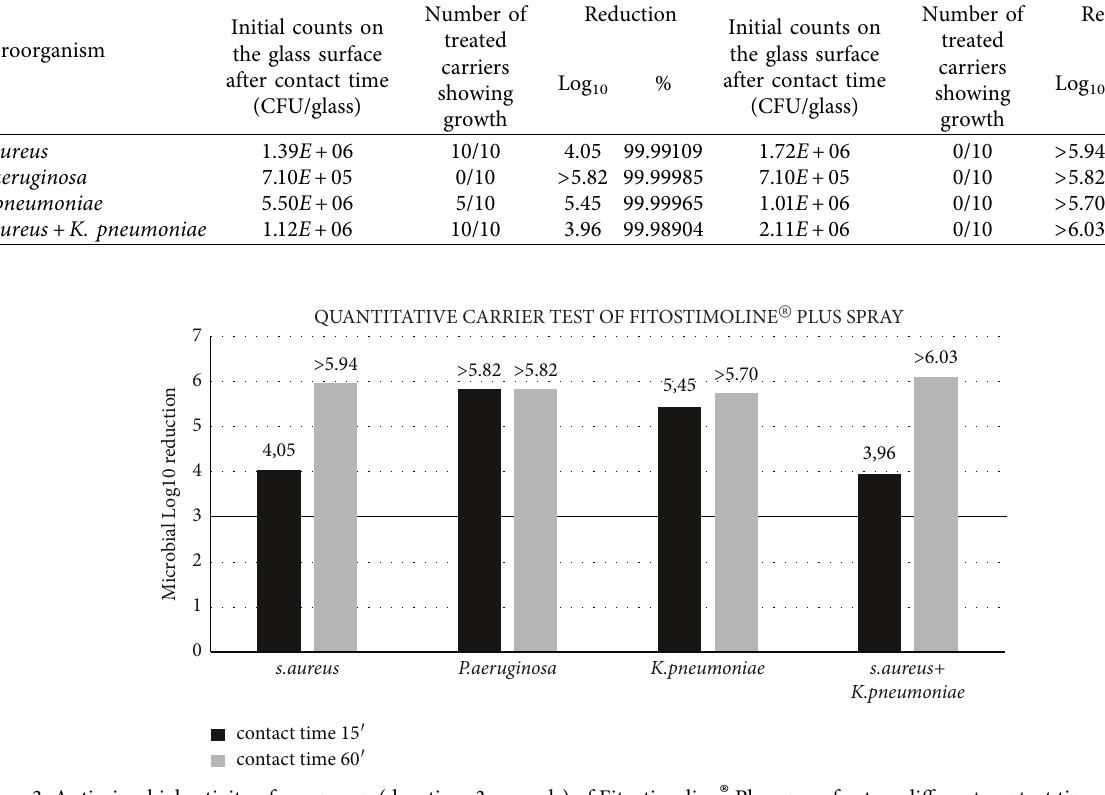
Table 3: Summary of the microbial log surface.